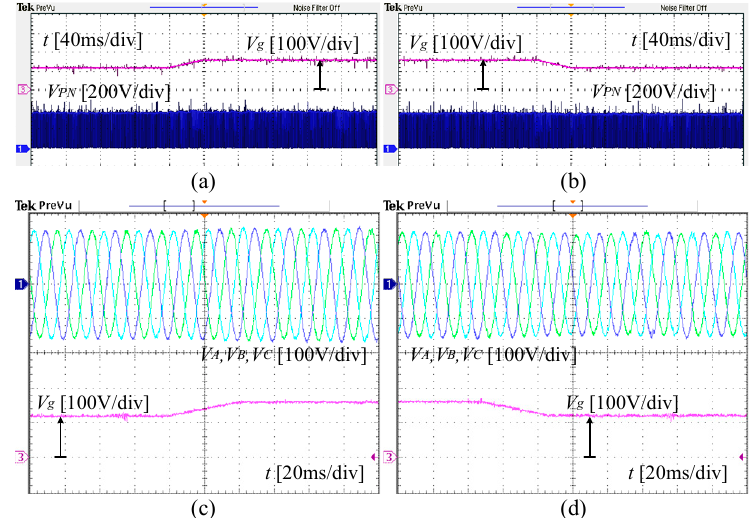
Figure 15. The experimental verification for DC-link voltage control and output load voltage control. ( a , c ) Input voltage increment, ( b , d ) input voltage decrement.